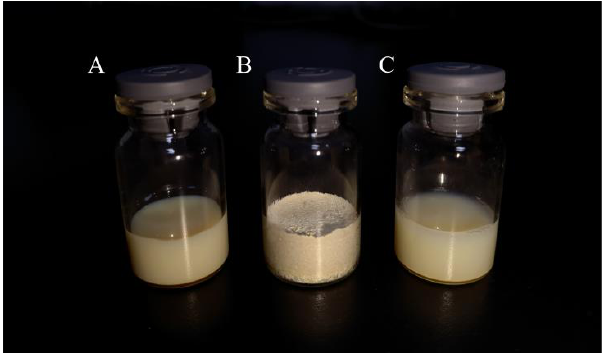
Figure 2. The physical appearance of Bre-NS ( A ), Bre-NS freeze-dried powder ( B ) and Bre-NS freeze-dried powder after redispersion ( C ).